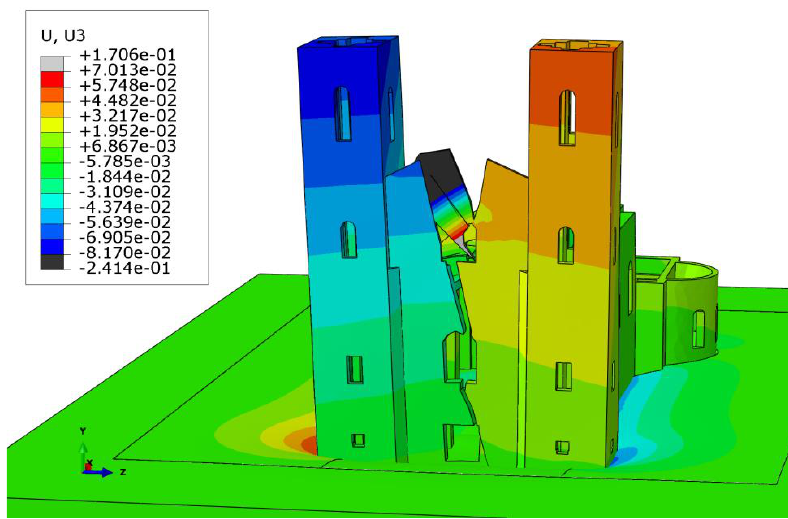
Figure 16. Horizontal displacement of the structure “north-south” direction (m).